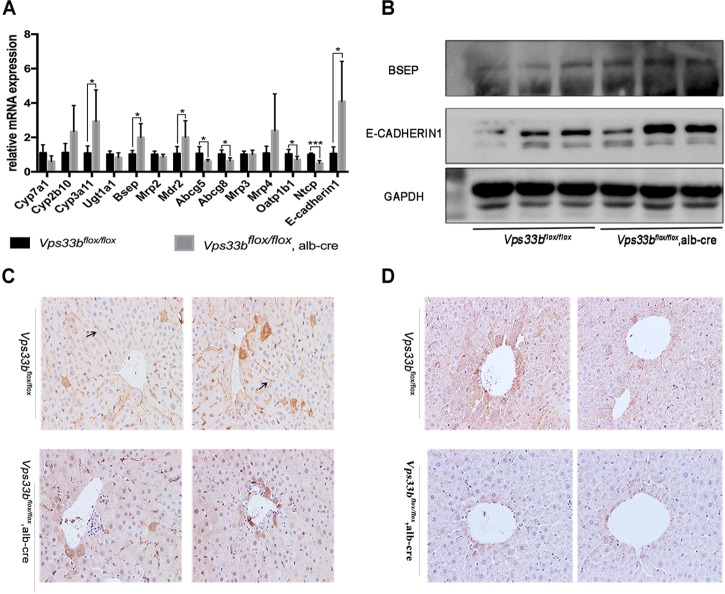
Bile homeostasis-related gene expression levels (A). Western blotting (B) and IHC (C) detection of BSEP, and E-cadherin1 (A,B) and CLAUDIN-1 (D) cell junction protein expression levels.